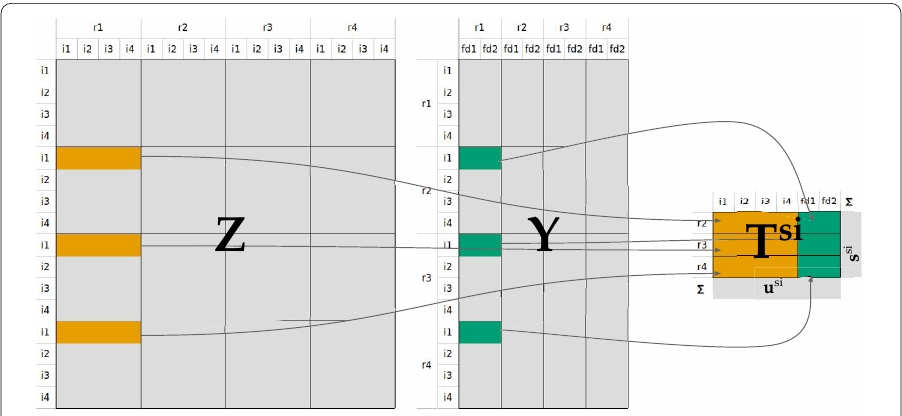
Fig. 1 A simplified MRIO system with four regions, four industries and two final demand categories to exemplify how the import matrix T si is extracted from the inter-industry matrix Z and the final demand matrix